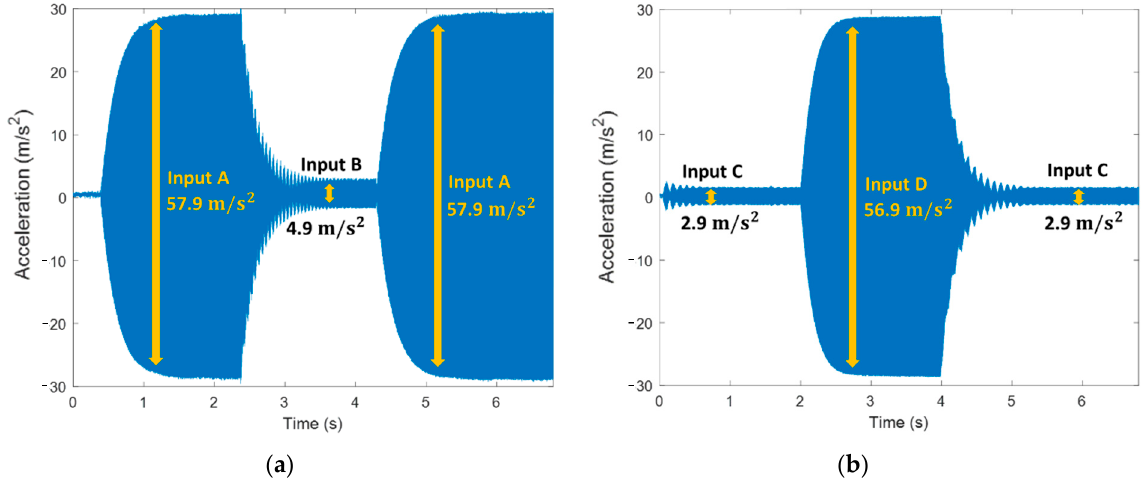
Figure 4. ( a ) Example showing an increase in vibration at one point in the beam; ( b ) example showing a decrease in vibration at one point in the beam.